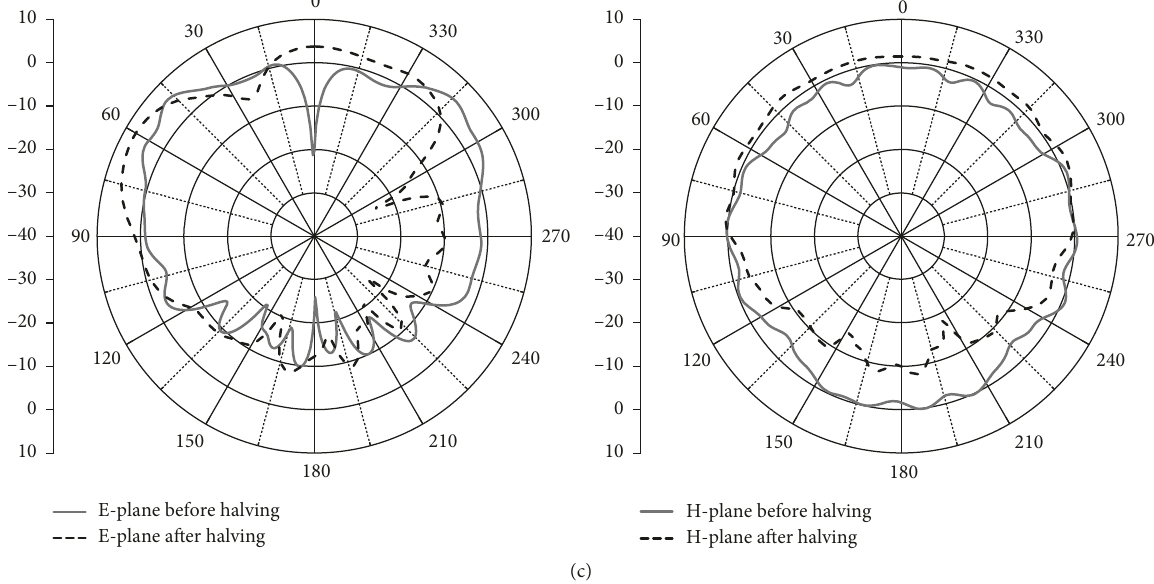
Figure 7: Effect of halving on radiation pattern at different frequencies. (a) 0.9 GHz, (b) 2GHz, and (c) 3.5 GHz.